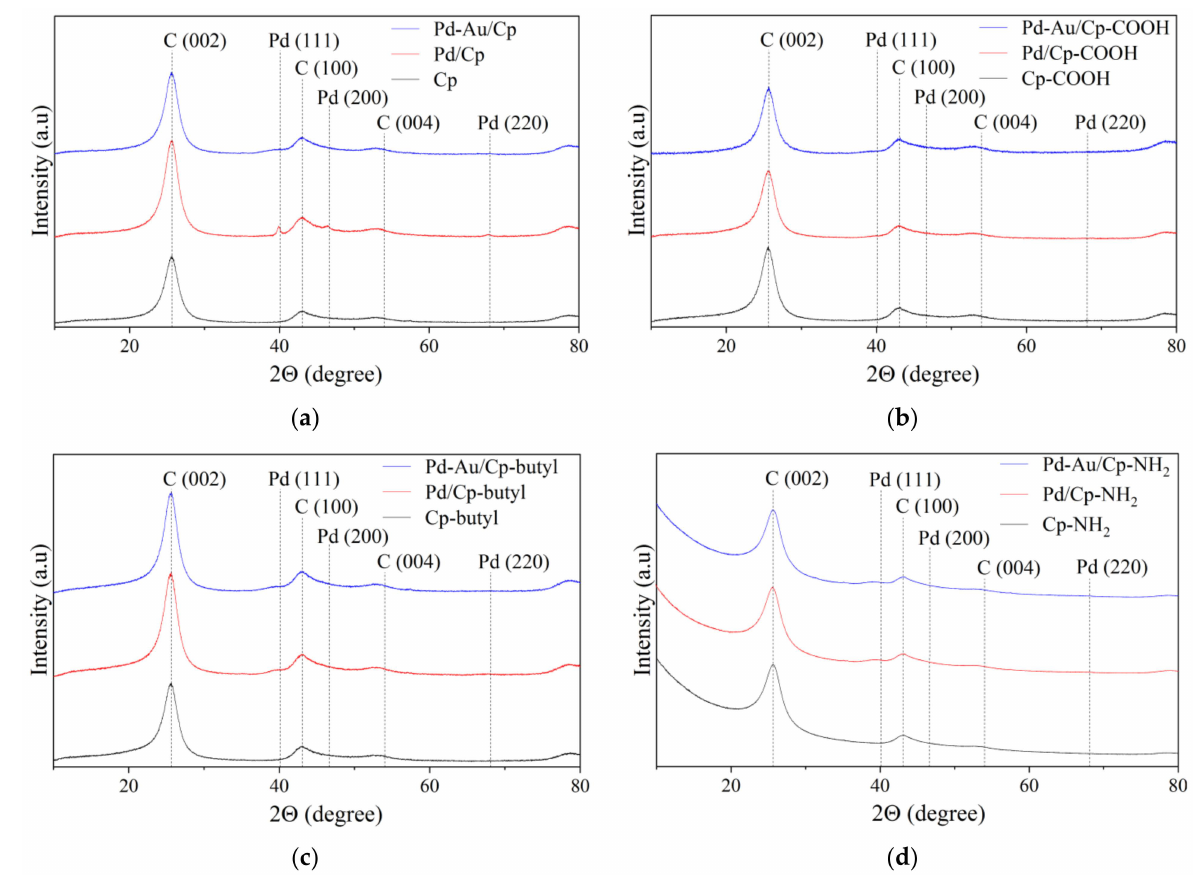
Figure 4. XRD patterns of catalysts and corresponding supports: ( a ) Cp, Pd/Cp and Pd-Au/Cp; ( b ) Cp-COOH, Pd/Cp-COOH and Pd-Au/Cp-COOH; ( c ) Cp-butyl, Pd/Cp-butyl and Pd-Au/Cp- butyl; ( d ) Cp-NH 2 , Pd/Cp-NH 2 and Pd-Au/Cp-NH 2